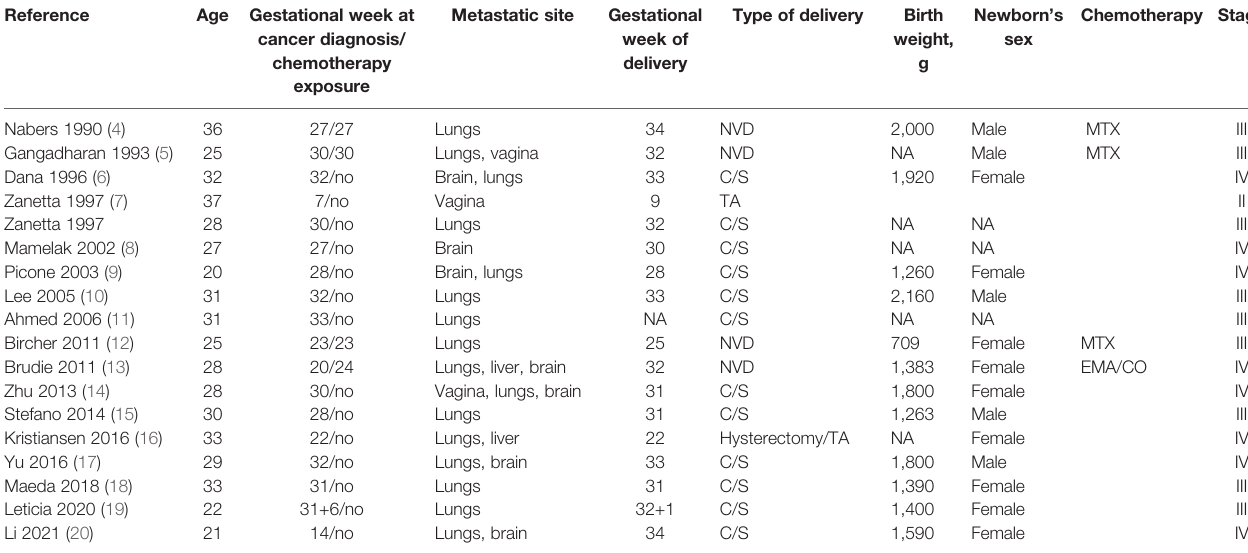
TABLE 1 | Summary of widespread metastasis of choriocarcinoma during pregnancy.